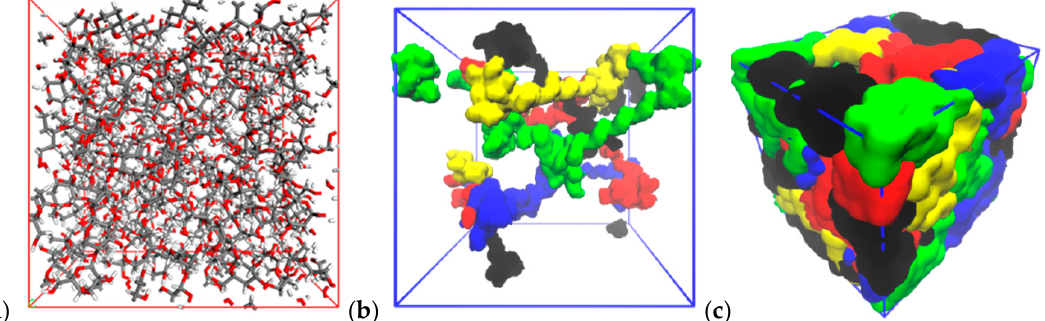
Figure 3. Visualization of ( a ) amorphous cellulose prepared by Monte Carlo method, the box is 3 × 3 × 3 nm 3 and amorphous xylan prepared by molecular dynamic relaxation, ( b ) before and ( c ) after densification, the box is 5 × 5 × 5 nm 3 .